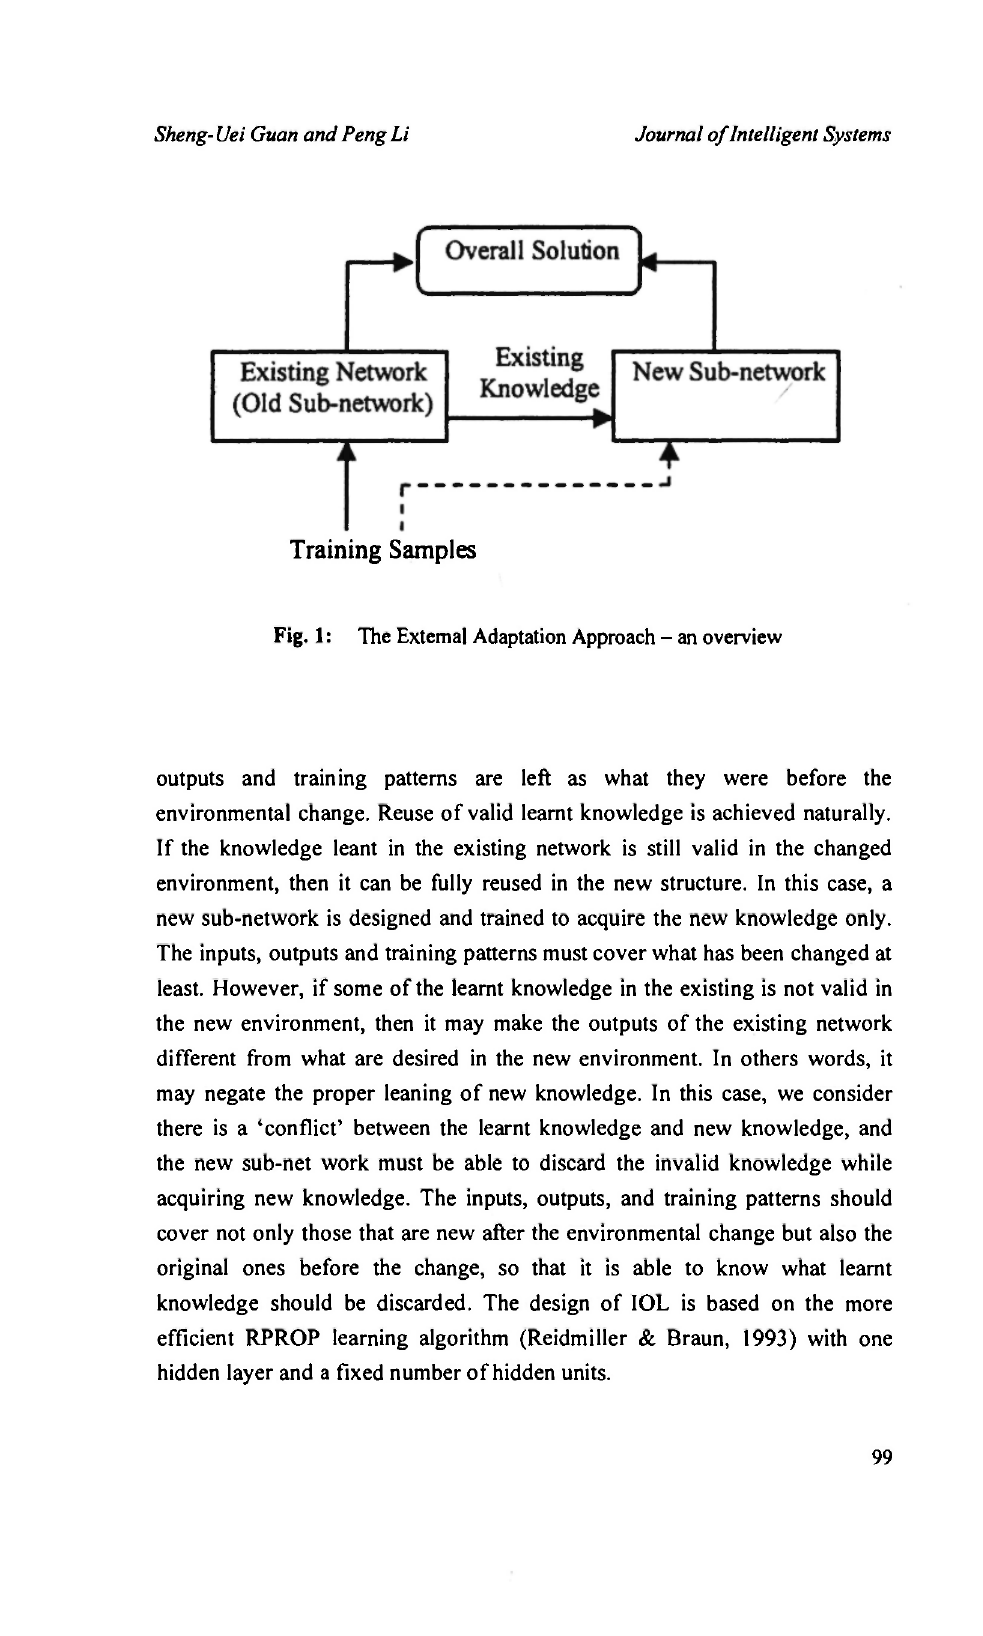
Fig. 1: The External Adaptation Approach - an overview